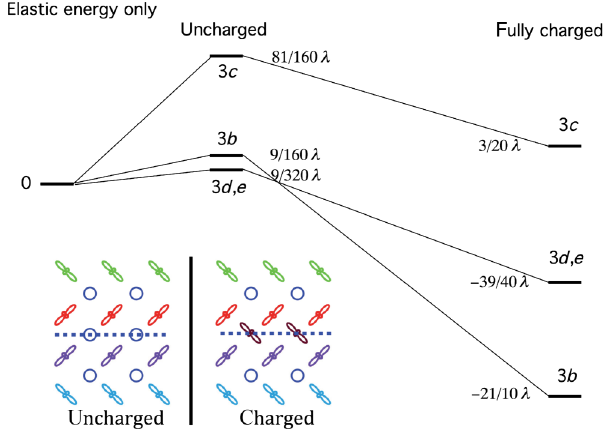
FIG. 1. The elastic energy levels of the configurations 3 b (shown as the inset), 3 c , 3 d , and 3 e for uncharged and fully charged ODW, where λ 0 = λ ¼ 3 = 10 . The energy levels of fully charged ODW are reduced by a factor of 2.5 in the